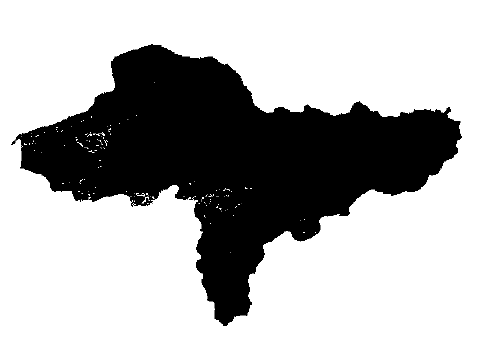
Figure 4 . Suitable solar panels areas for slope 30°-45° Since the suitable areas for slope 30°-45° are relatively small, two additional slope conditions are calculated, from 27° to 31° (Figure 5) and from 10° to 20° (Figure 6), which are according